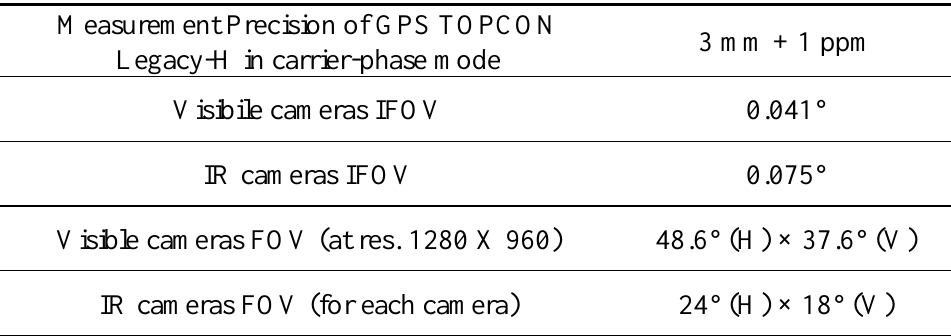
Table 1. Camera accuracies and fields of view.